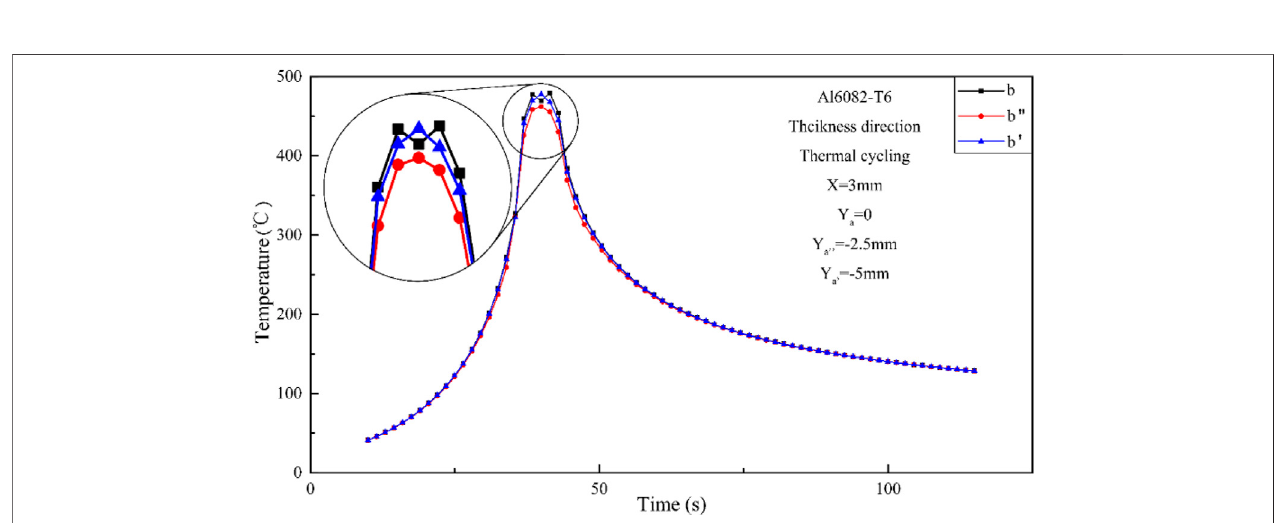
FIGURE 10 | Thermal cycle curves of each feature point in the thickness direction at a distance of 3 mm from the center of the weld.